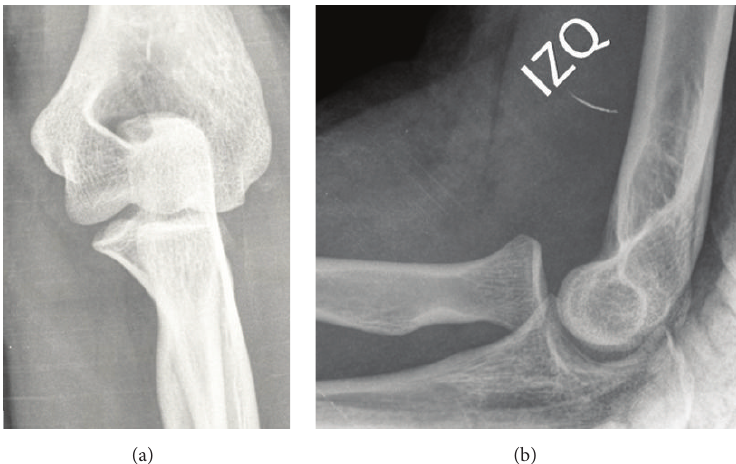
Figure 1: Left elbow anteroposterior (a) and lateral (b) X-ray where the medial and anterior dislocation of the radial head can be observed. No pathology is observed on the ulnohumeral joint.